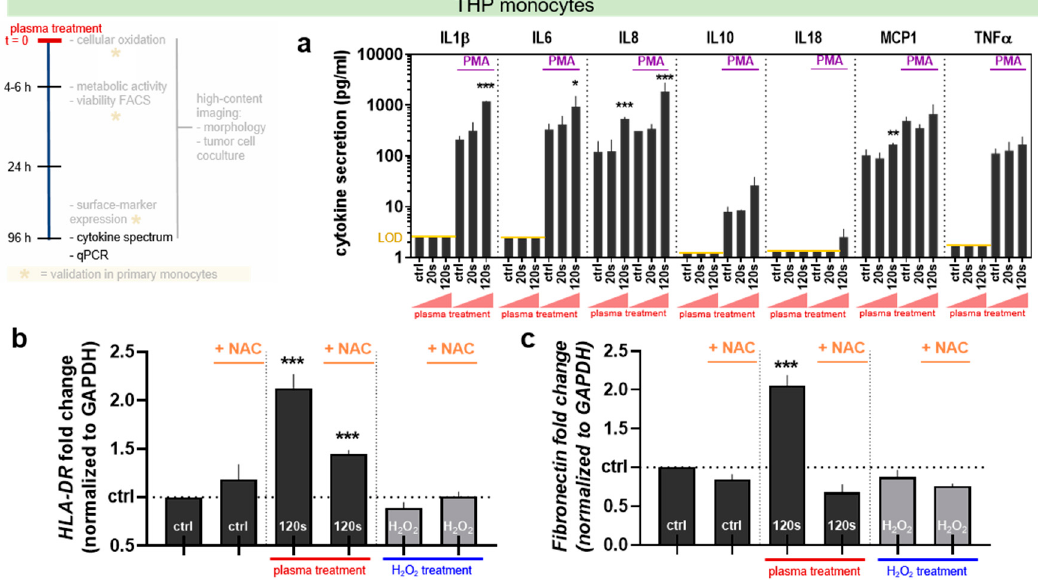
Figure 5. Plasma and PMA alters cytokine secretion in THP-1 monocyte and the cells’ gene expression four days post treatment. ( a ) Cytokine content in the supernatant of untreated and plasma-treated THP-1 monocytes ( ± PMA) in pg / mL. The limit of detection of several cytokines is indicated as a yellow line, and IFN α , IFN γ , IL12p70, IL17A, IL23, and IL33 were not detectable in any sample (data not shown). ( b ) The modulation of HLA-DR and ( c ) fibronectin gene expression analyzed with qPCR in 120 s plasma or 300 µ M hydrogen peroxide (H 2 O 2 ) treated THP-1 monocytes with or without PMA. All samples and data ( a – c ) are pooled from three independent experiments with four technical replicates each and are displayed as the mean + SD. The statistical analysis was performed using two-way anova with Dunnett post-testing to respective controls. The seconds (s) indicate plasma treatment time, ctrl = control.